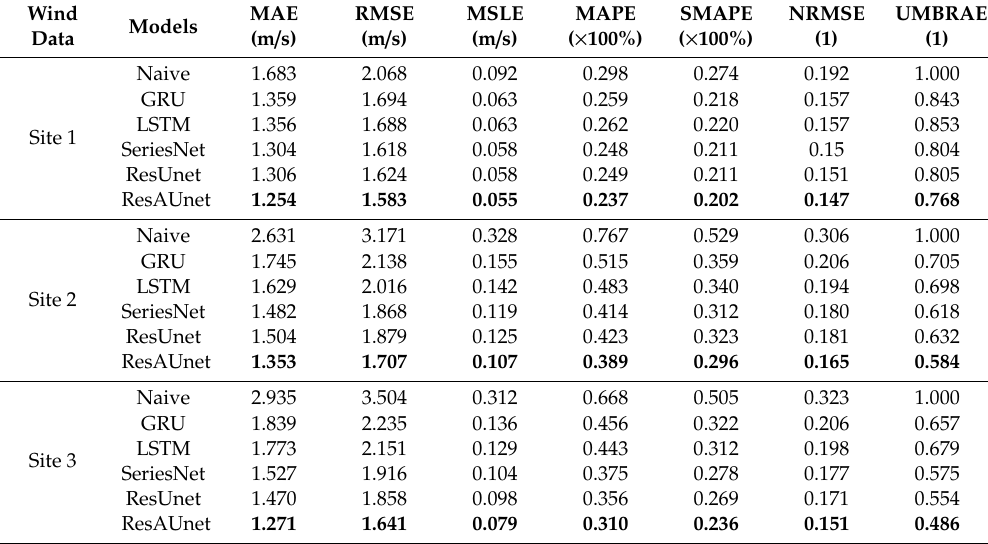
Table 9. Error metrics of di ff erent models on six site’s wind speed data. SMAPE, “symmetric” MAPE; UMBRAE, mean bounded relative absolute